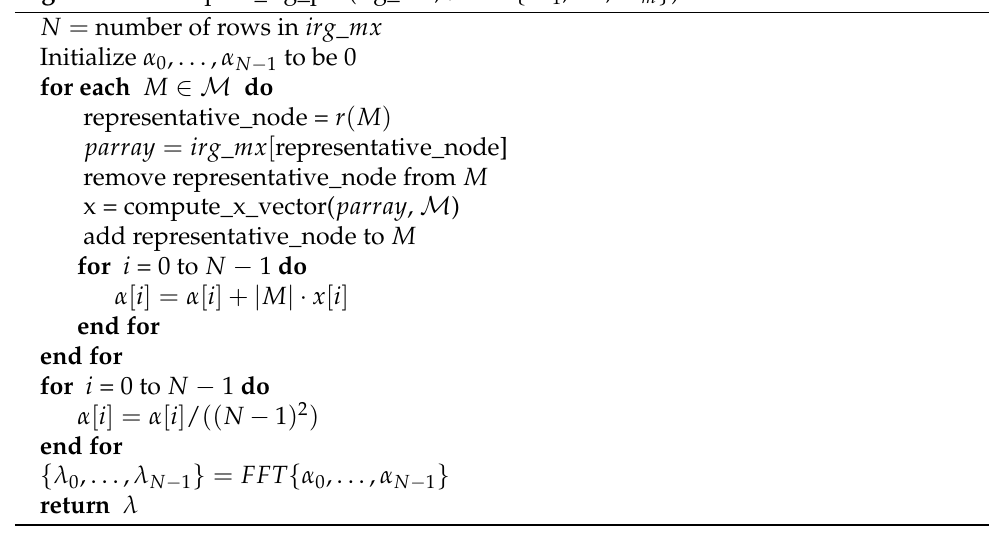
Algorithm 2 compute_irg_pdf(irg_mx, M = { M 1 , . . . , M m } )